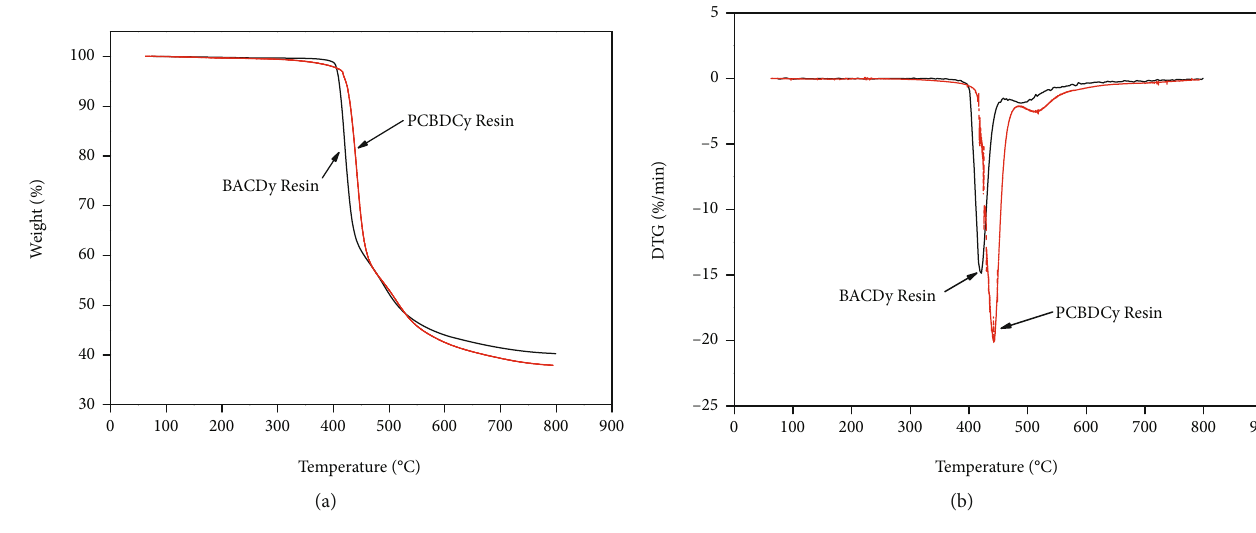
Figure 6: TG (a) and DTG (b) curves of cured PCBDCy and